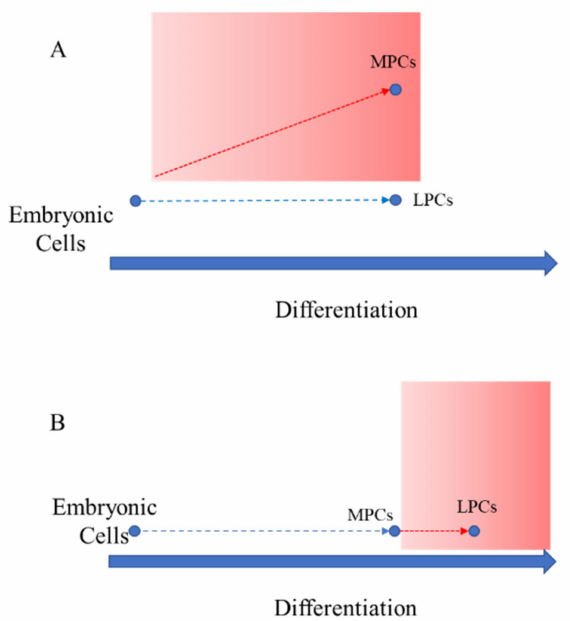
Figure 1. Two different hypotheses for the origin of miRNAs differentially regulated between M- MSCs and L-MSCs. ( A ) M-MSCs and L-MSCs are the results of divergent differentiation from embryonic stem cells; ( B ) embryonic stem cells physiologically differentiate in M-MSCs, and further pathological differentiation produces L-MSCs. The red areas indicate the spectrum of the disease. The red arrows show the pathological